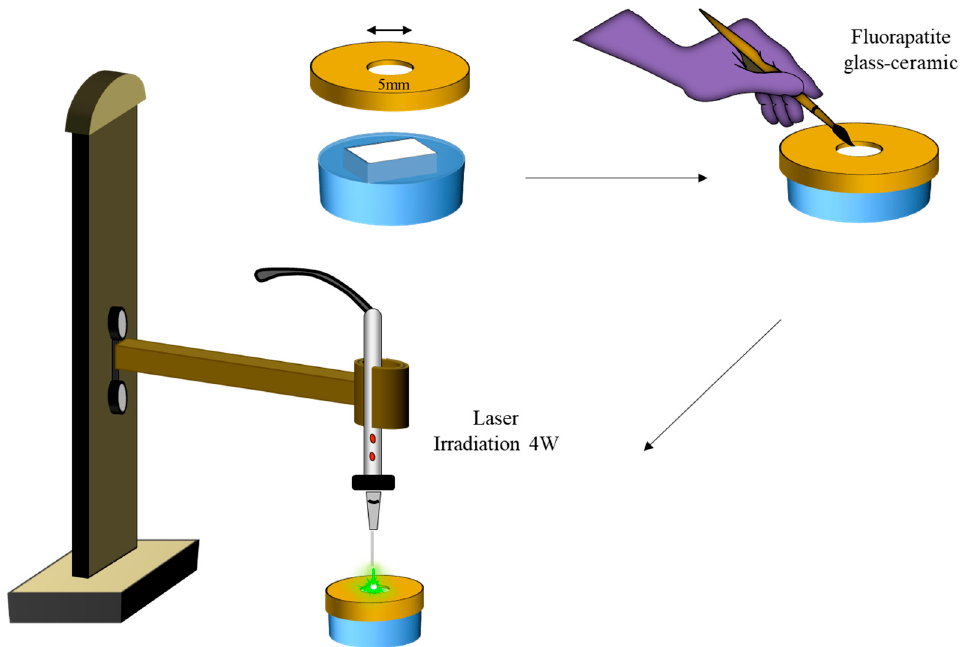
Figure 2. Schematic diagram showing FGC+ Nd: YAG approach. A brass metal cover with a central hole of 5 mm in diameter and 0.5 mm thickness was used to define the area of the zirconia surface to be irradiated with a laser. A paint brush was used to coat the exposed area with FGC powder. Nd: YAG laser handpiece was mounted into a carrier so that the irradiation was perpendicular to the exposed zirconia surface at a fixed distance of 1 mm. Group D (Control): As